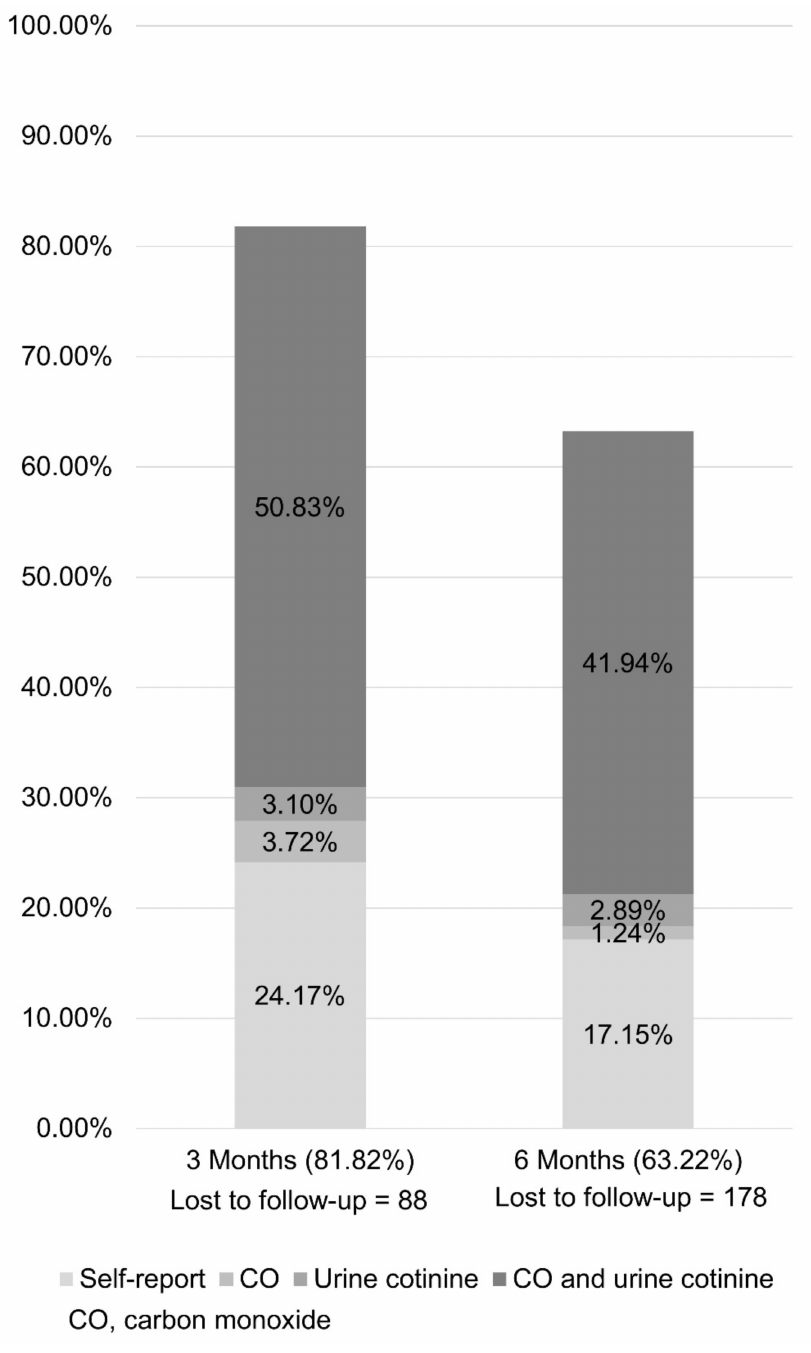
Figure 2. Abstinence rate by